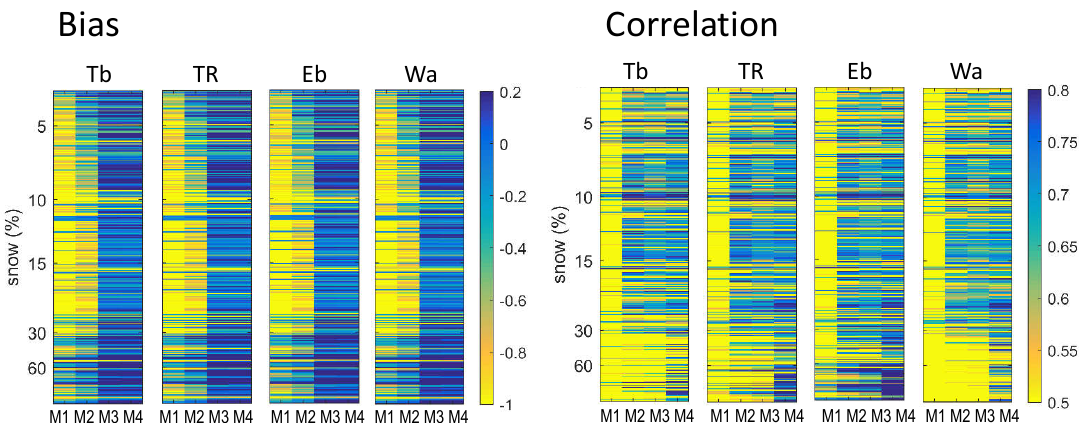
Figure 9. Bias and correlation for all catchments. Panel A : For both forcings and all snow models with the SD_av snow parameters. Panel B : For all snow models and all approaches for estimating the snow parameters. Unless otherwise stated, the M4 hydrological model driven by the Livneh forcing with a priori soil parameters was used.